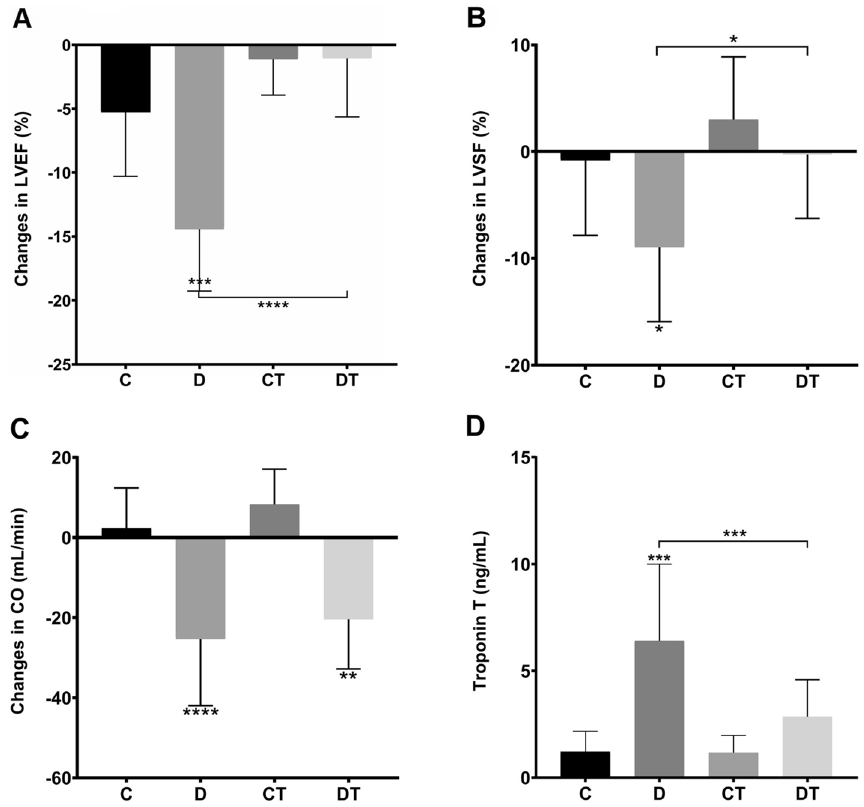
Figure 3. Preventive aerobic exercise training preserved cardiac function of doxorubicin-treated animals. ( A ) Mean changes in left ventricle ejection fraction (LVEF) and ( B ) shortening fractional (LVSF) from baseline to final assessment (%);( C ) Mean changes in cardiac output (CO, mL/min); ( D ) Cardiac Troponin T (ng/mL). C: control (n = 10; for Troponin T: n = 8); D: doxorubicin-treated (n = 10; for Troponin T: n = 9); CT: control-trained (n = 10; for Troponin T: n = 7); DT: doxorubicin-trained (n = 10; for Troponin T: n = 8). One-way ANOVA and Tukey’s post-hoc. *p < 0.05, **p < 0.01, ***p < 0.001, ****p < 0.0001 above error bars in comparison to control